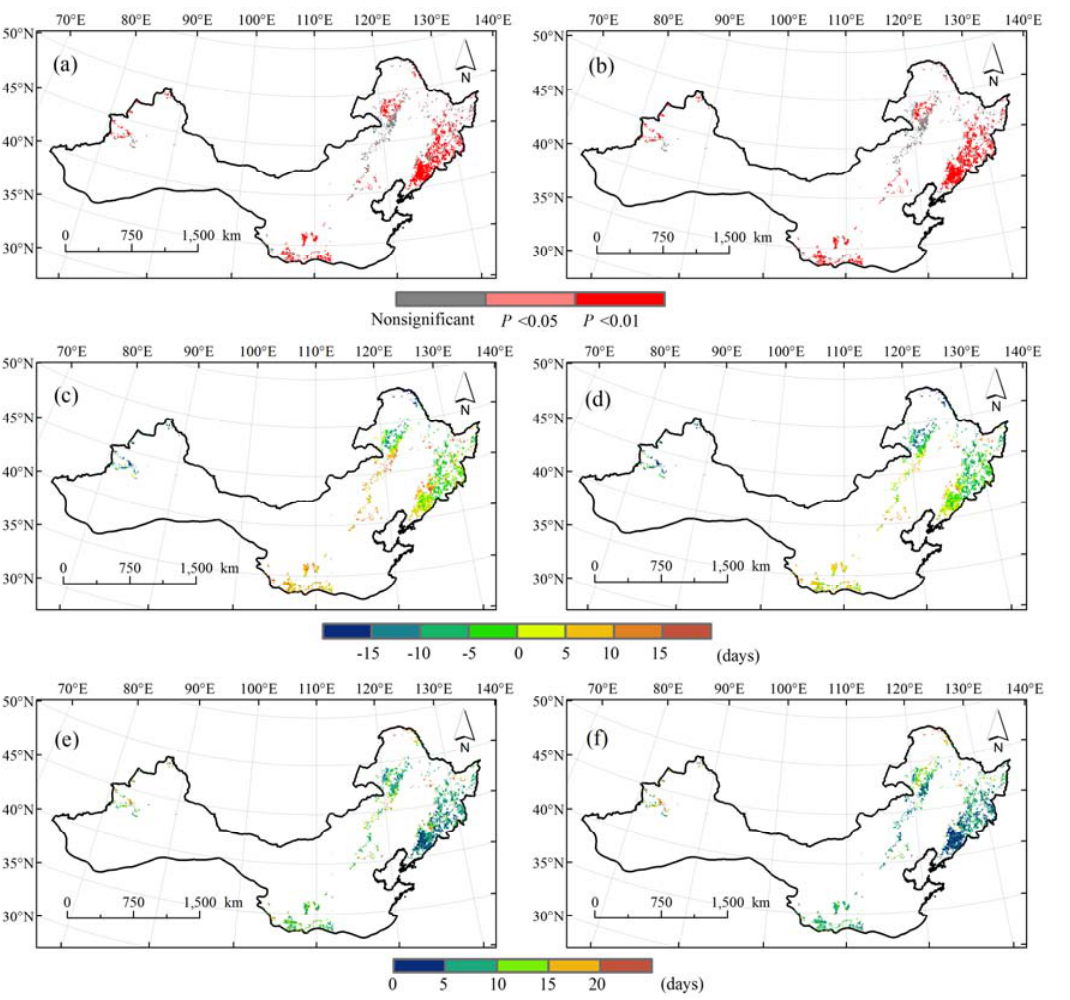
Figure 5. Spatial patterns of temporal correlation coefficients and mean differences between SOS (SOS3g) and BGS at each pixel from 1986 to 2006. ( a ) correlation coefficients between SOS and BGS; ( b ) correlation coefficients between SOS3g and BGS; ( c ) ME between SOS and BGS; ( d ) ME between SOS3g and BGS; ( e ) MAE between SOS and BGS; ( f ) MAE between SOS3g and BGS.